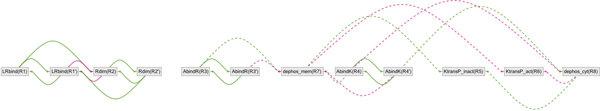
The influence graph. Nodes represent reaction rules while arcs represent influence between rules. Green/Magenta solid arcs represent fully activation/inhibition, and Green/Magenta dash arcs represent partial activation/inhibition. Filter options that show or hide activation/inhibition are provided through pop-up menus. Two separate groups of rule nodes (group1: the first four nodes, group2: the rest of the nodes). can indicate that the model is not complete.